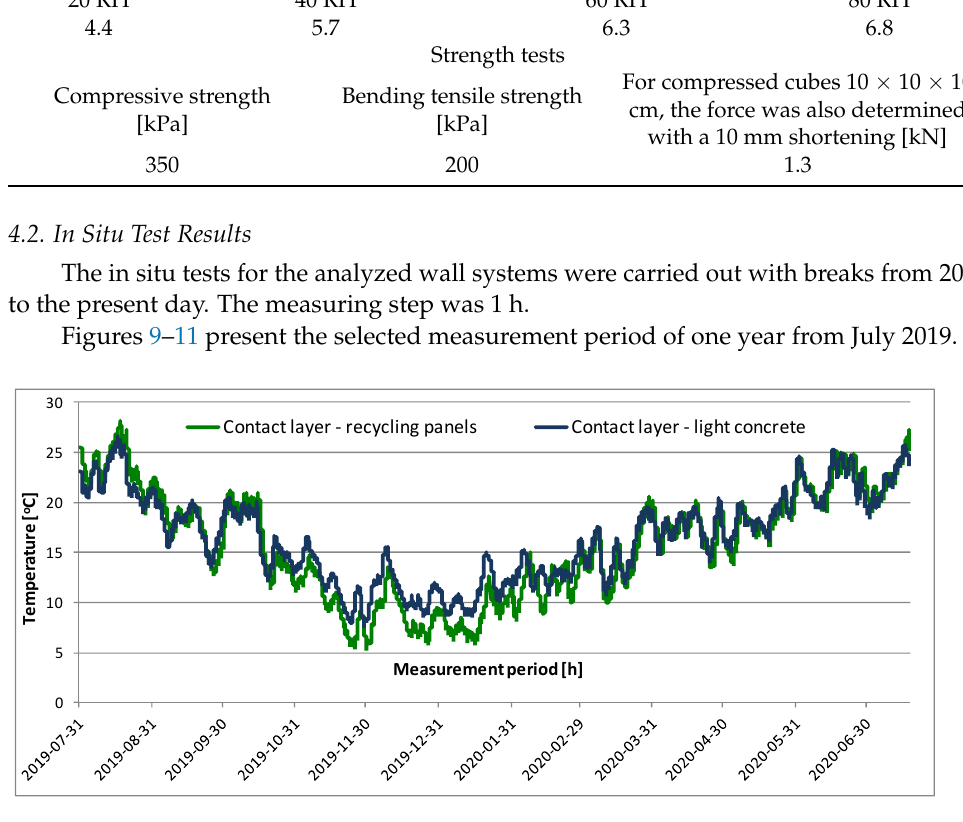
Figure 9. Profile of temperature changes in the contact layer.